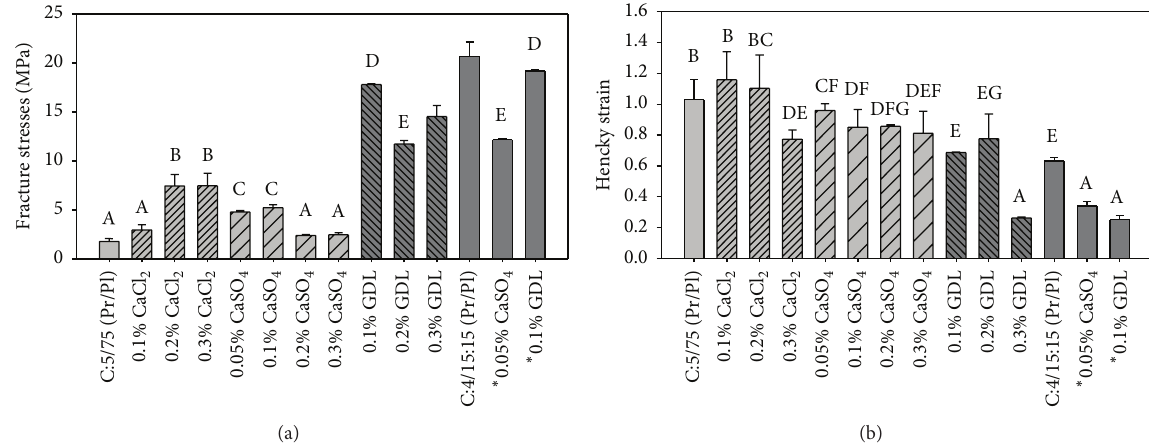
Figure 4: Fracture stresses (a) and Hencky strain (b) of films prepared with formulations 5PC-75S and 4PC-15G/15S.Note: values in a column with different letters are significantly different at 𝑝 < 0.05